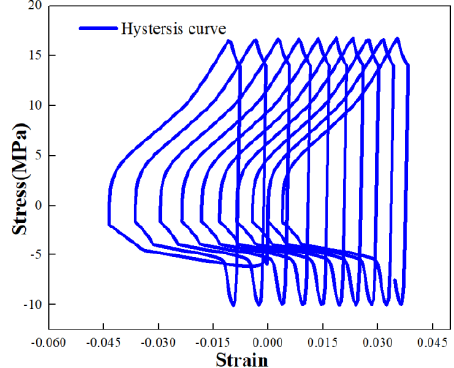
Figure 12: Cyclic stress/strain curves of solder layer TIM2